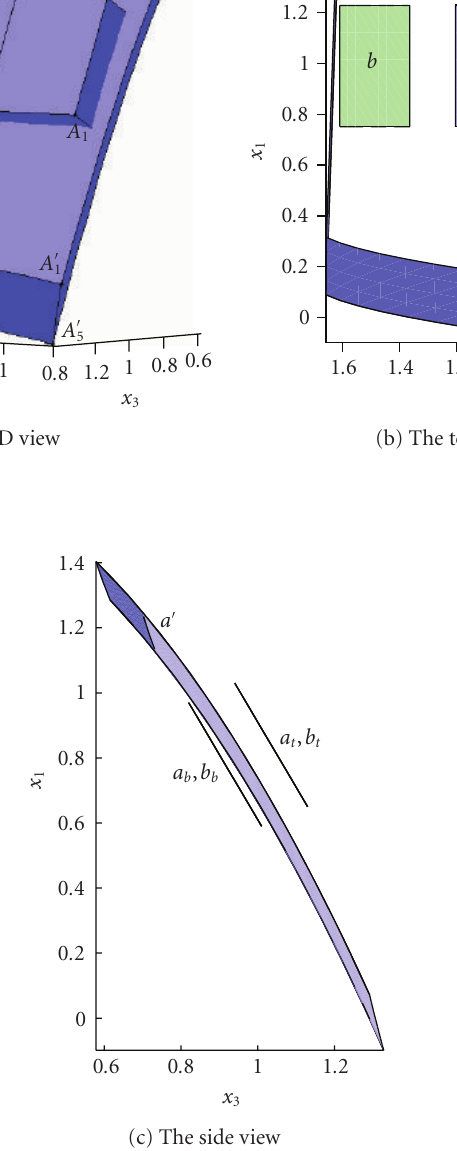
Figure 3.4. a (cid:9) 4 ( a ) wholly across a and b